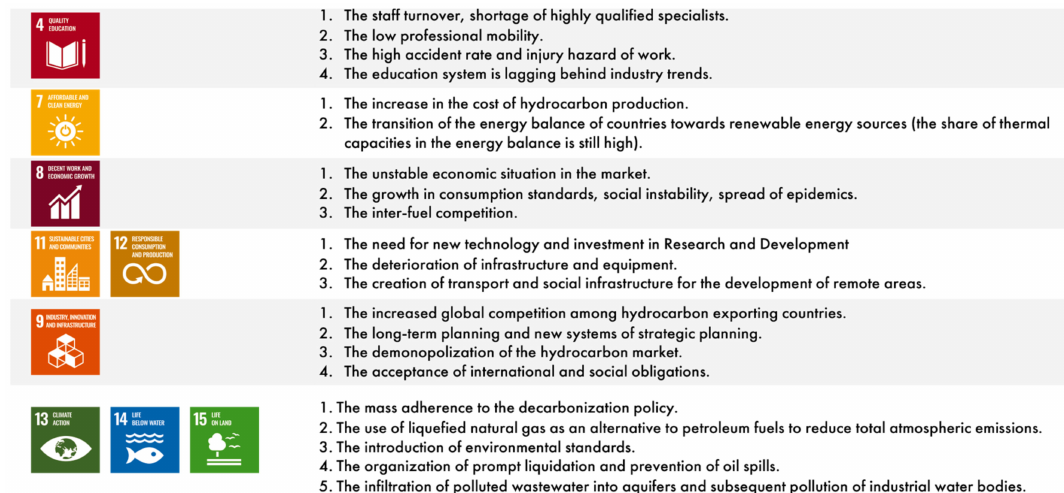
Figure 1. The rationale for choosing nine out of 17 SDGs in accordance with the modern trends in the fossil energy